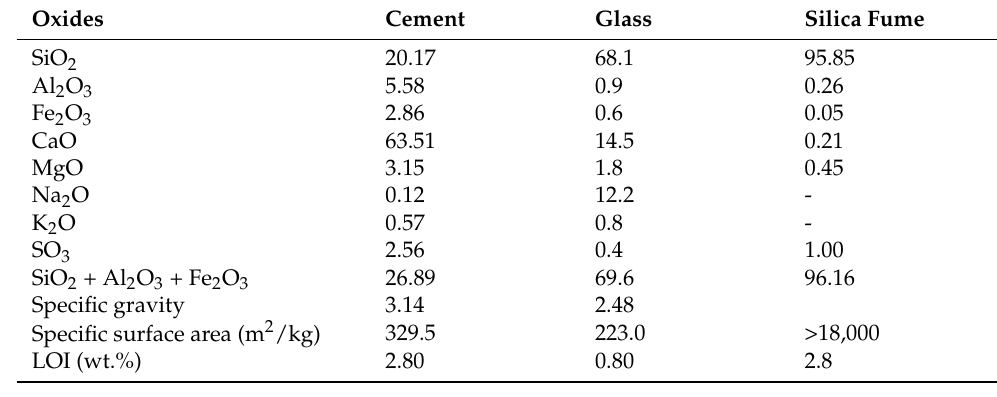
Figure 1. Glass waste at dumpsite in Hafr Al-Batin. Table 1. Oxide composition of raw materials.